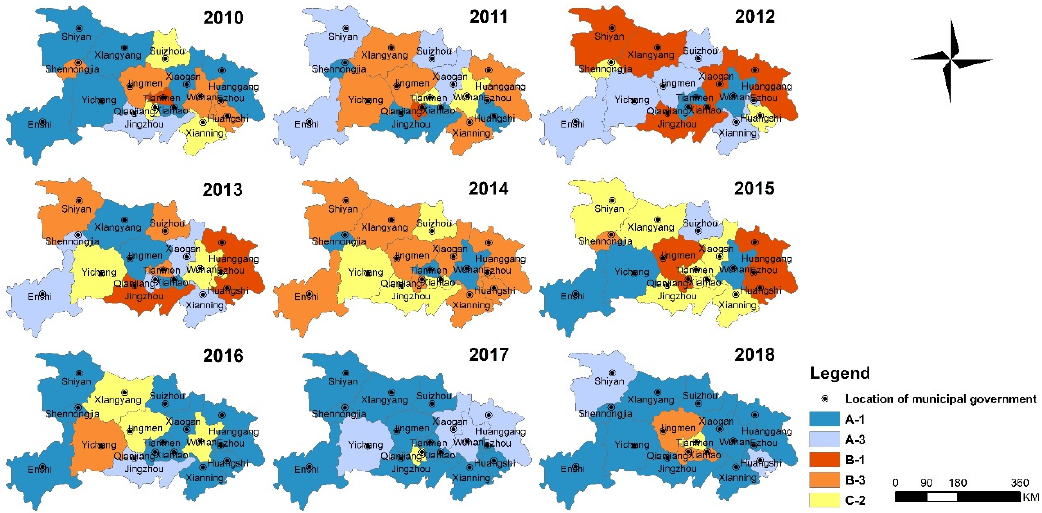
Figure 6. The spatial distribution of SCDI in Hubei Province during 2009–2018.